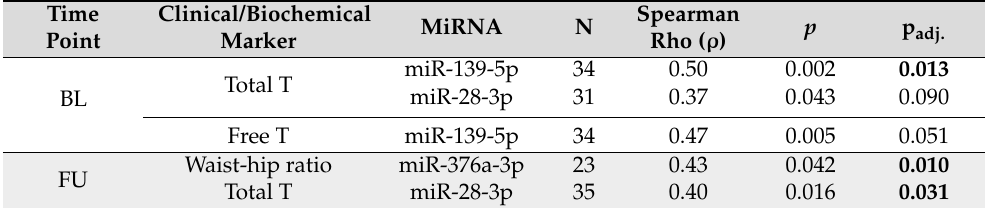
Table 3. Correlation between clinical and biochemical markers with the four selected miRNA within the PCOS women. The individual time points (BL or FU) are kept separate. Spearman rho is displayed, as well as the number of women included. P adj (two-tailed, partial correlations): correlations between the selected variable controlling for age and BMI at the respective time points. N: number of PCOS women included in the